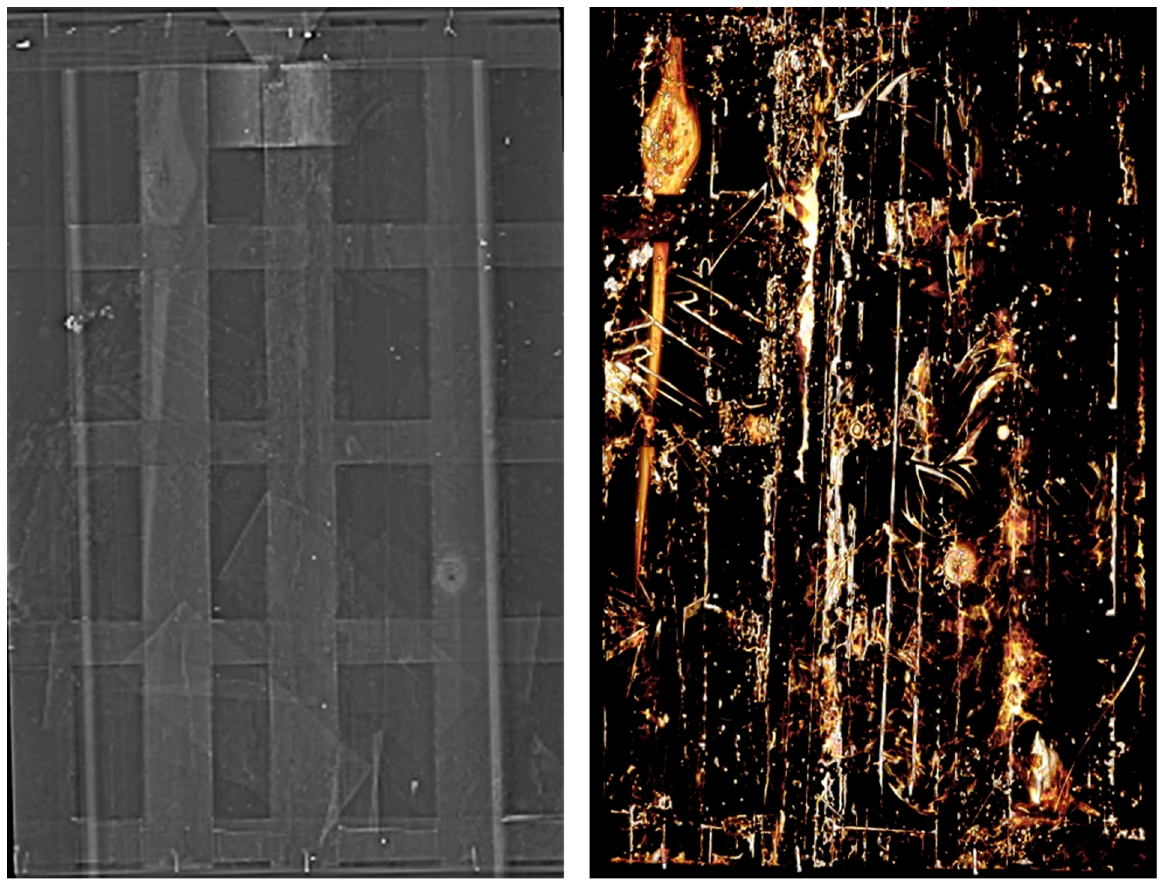
Figure 6. CT scan. ( Left ) wide bandage folded several times in a zig zag and a trapezoidal wooden insert with a hook; ( right ) Greek letters.